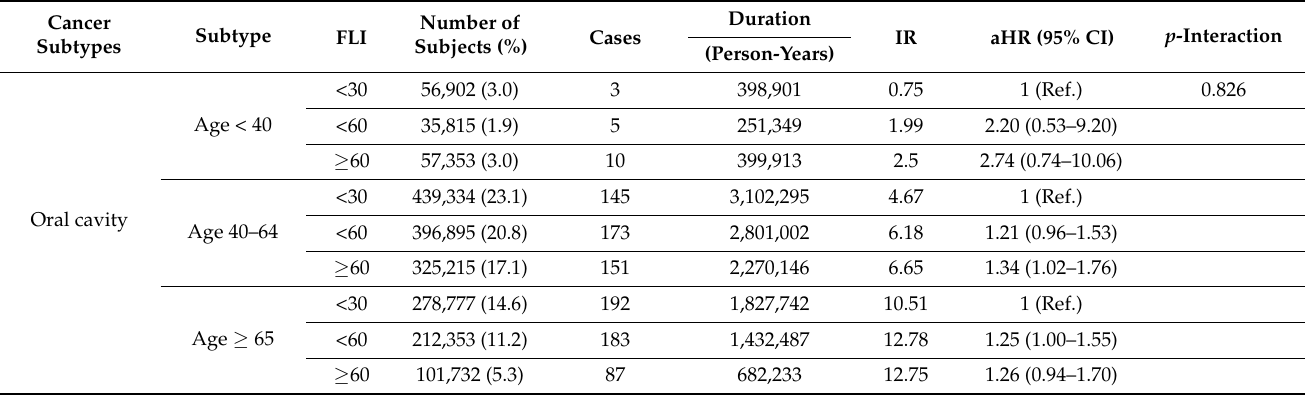
Table 4. Adjusted hazard ratio (aHR) and 95% confidence interval (CI) for head and neck cancer in DM patients according to the combination of age and fatty